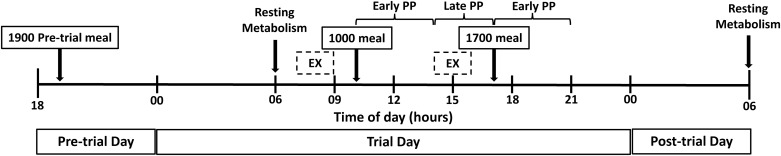
Study protocol.EX, 2-hour moderate-intensity exercise in the exercise trial; Early PP, early postprandial period; Late PP, late postprandial period.